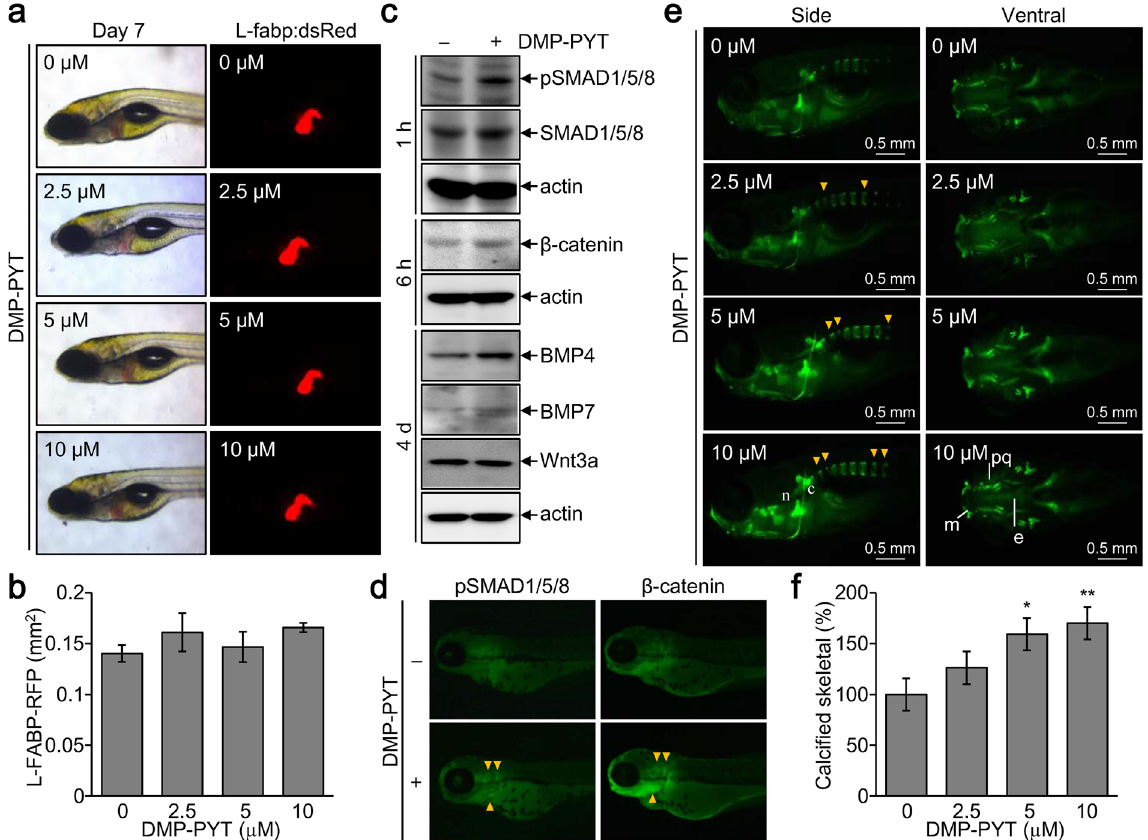
Figure 6. Increased calcified skeletal development by DMP-PYT in vivo . L-Fabp:dsRed zebrafish embryos (n = 10) were incubated with the indicated amounts of DMP-PYT for 6–7 days post fertilization. ( a ) Zebrafish were observed under a fluorescence stereomicroscope and ref fluorescence was observed in the liver. ( b ) The hepatic size showing red fluorescence was quantitatively determined from 10 larvae images by automatically calculating the fluorescent area (mm 2 ) in the liver. ( c , d ) Zebrafish larvae (n = 10) at day 3 post fertilization were treated with DMP-PYT for 1 h, 6 h, and 4 days and harvested for immunoblotting analysis. Protein blots were incubated with antibodies against pSMAD1/5/8, SMAD1/5/8, β -catenin, BMP4, BMP7, Wnt3a, β -actin, followed by enhanced chemiluminescence and autoradiography ( c ). Fish larvae that were treated with DMP- PYT for 1 and 6 h and subjected to immunohistochemistry of pSMAD1/5/8 and β -catenin ( d ). ( e ) Skeletal development of zebrafish was visualized by calcein staining at day 7 post fertilization. Side view of the head skeleton: n, notochord; c, cleitrum. Ventral view of the head skeleton: m, Meckel’s cartilage; pq, palate quadrate; e, ethmoid plate. Arrowheads indicate the increased bone formation in vertebrate skeleton. ( f ) Calcification of axial skeleton was quantitatively determined from 10 larvae images using image J software and expressed as the percentage of the control. * P < 0.05 and ** P <